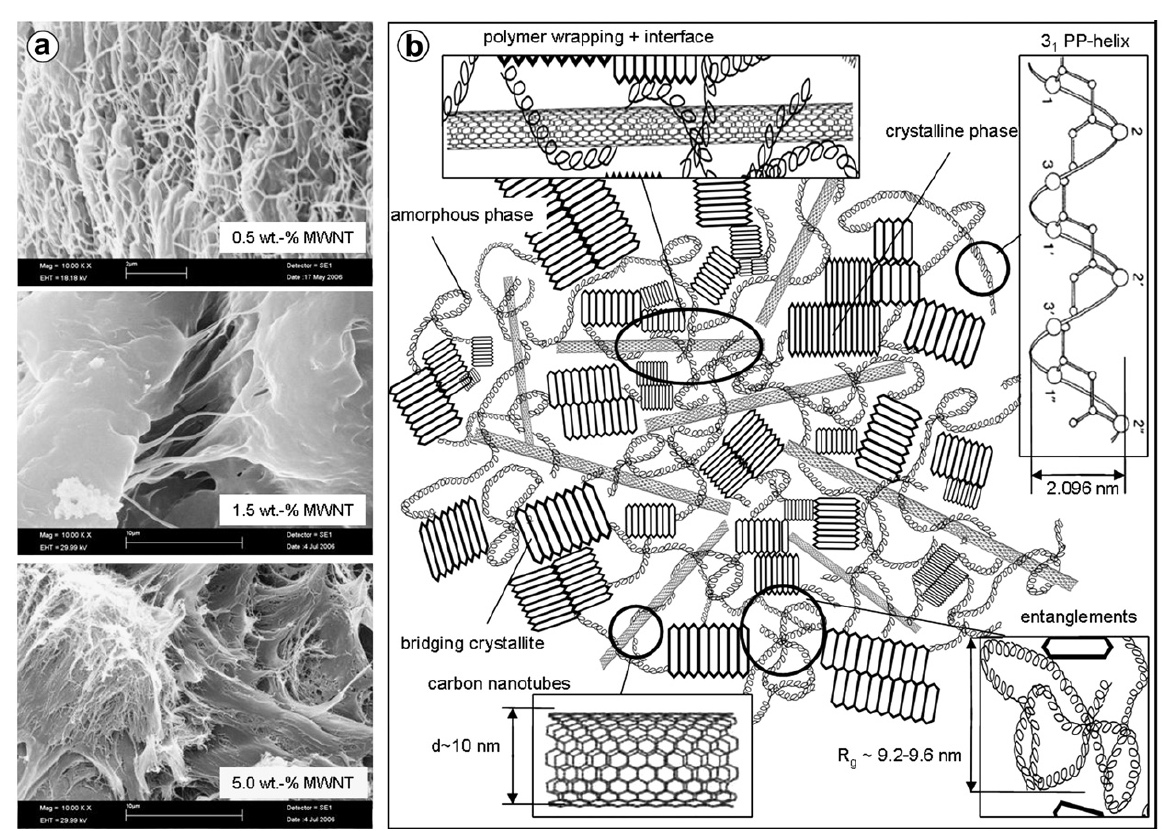
Figure 15. a) SEM investigation: fracture surfaces of nanocomposites with 0.5, 1.5 and 5.0 wt. % MWCNTs, and b) proposed schematic of the state of structural organization